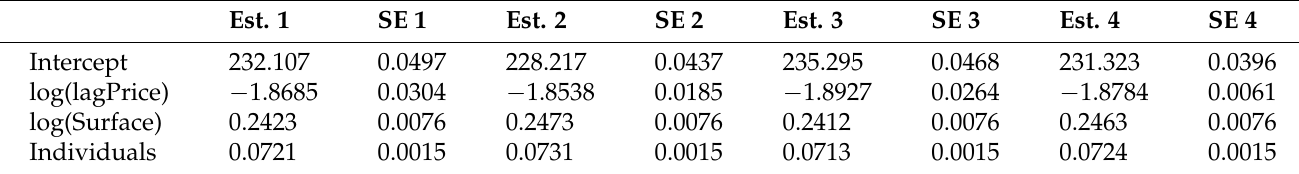
Table A2. Mixed models results. Randomness in the slope.